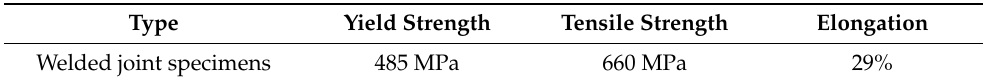
Figure 23. Schematic of tensile fracture of welded-joint specimens. Table 8. Tensile test results of welded-joint specimens.